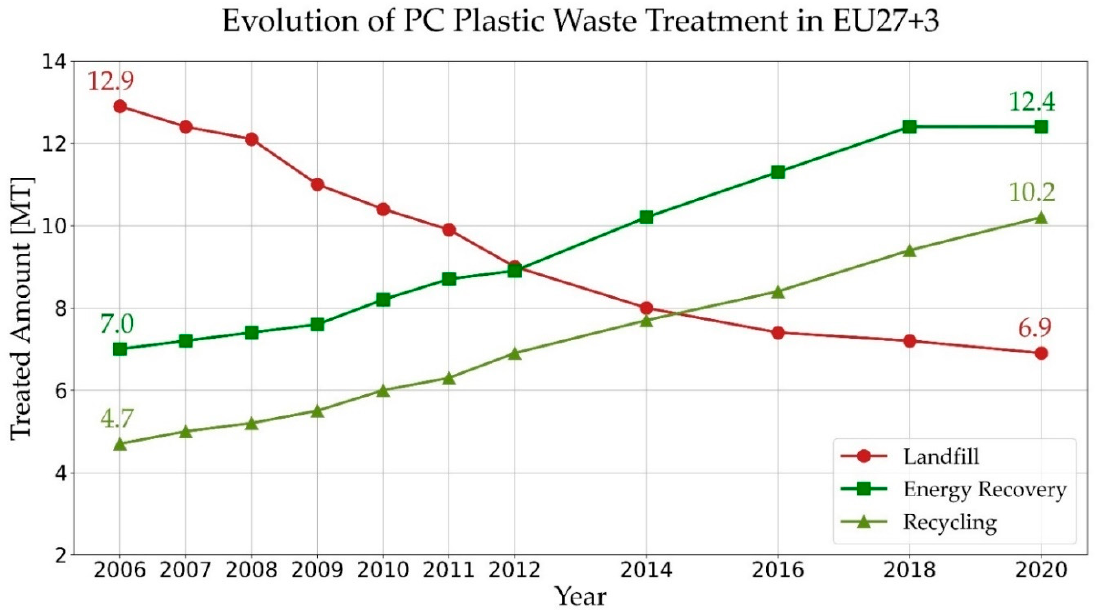
Figure 1. The evolution of the share of treatment methods for the post-consumer (PC) plastic waste in EU member states, Norway, Switzerland, and the United Kingdom (adapted from [4]).